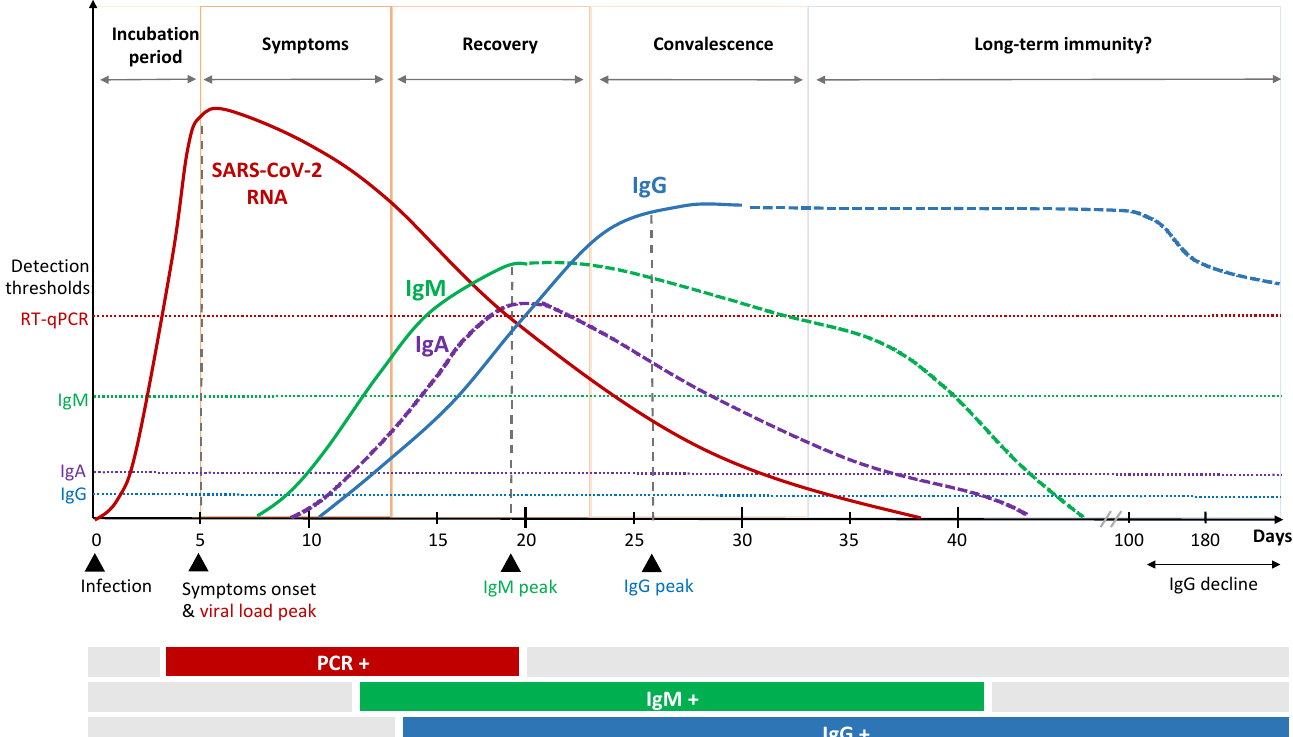
Figure 2. Kinetics of immune response to SARS-CoV-2 infection.